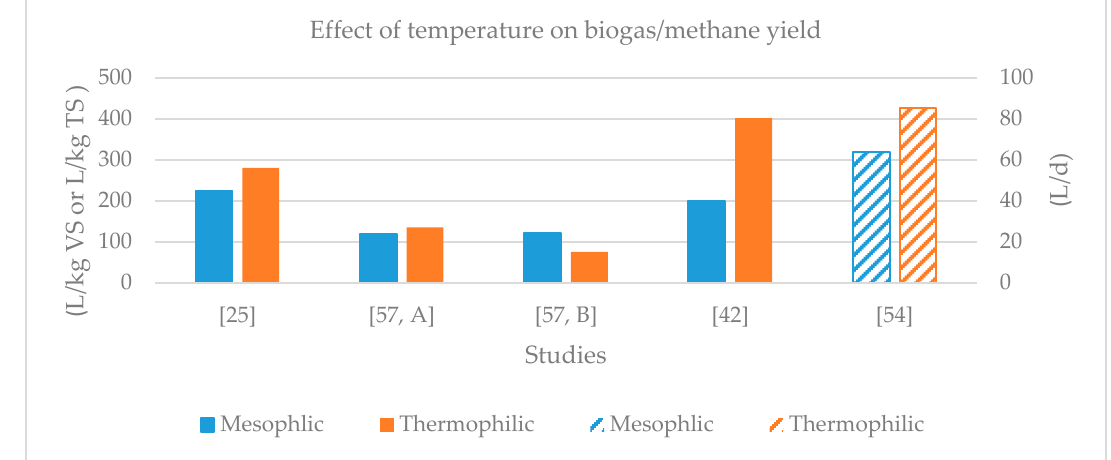
ff ect of temperature on biogas / methane yield Figure 4. Effect of temperature on biogas/methane yield [25,42,54,57]. Figure 4. E